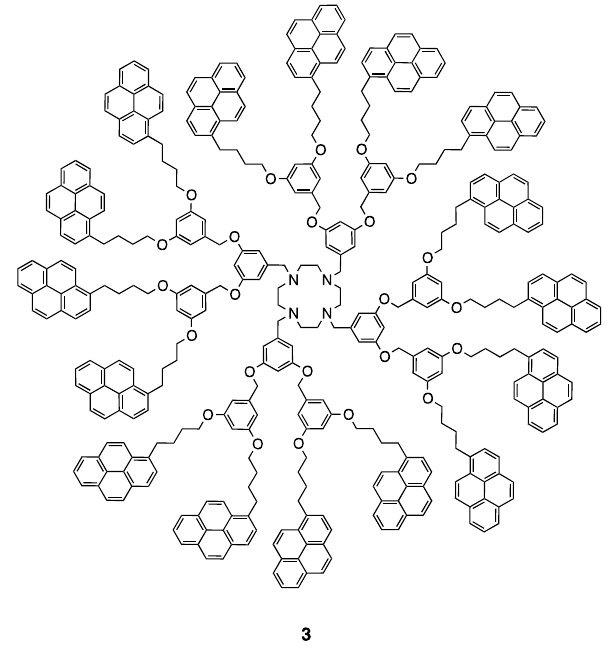
Figure 15. Structures of the cyclen-based ligand containing 16 pyrene units [50].